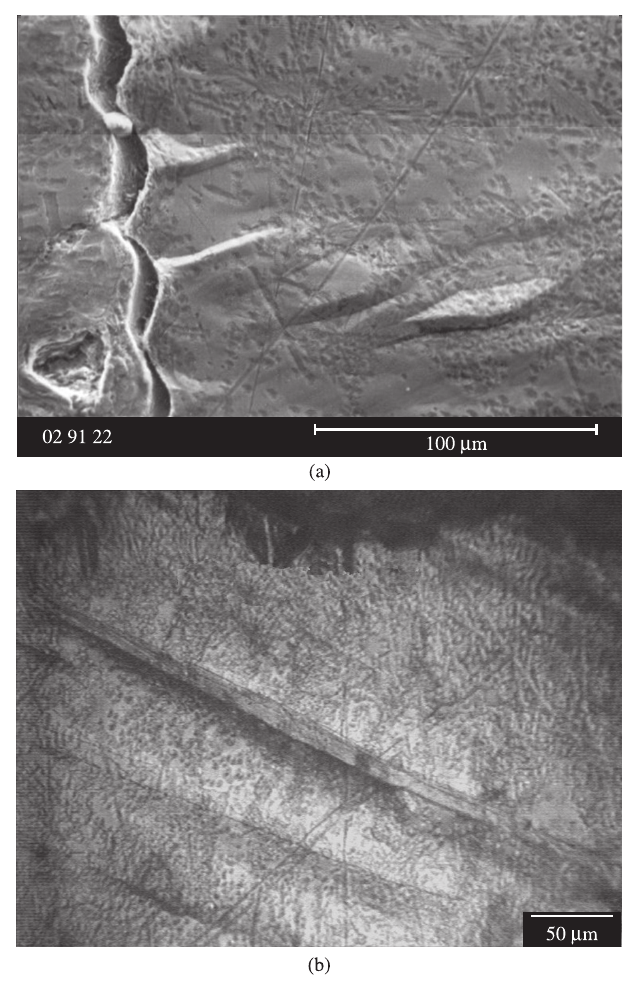
Figure 4. Micrographs of stretched great spangle samples. a) SEM; b) Opti- cal